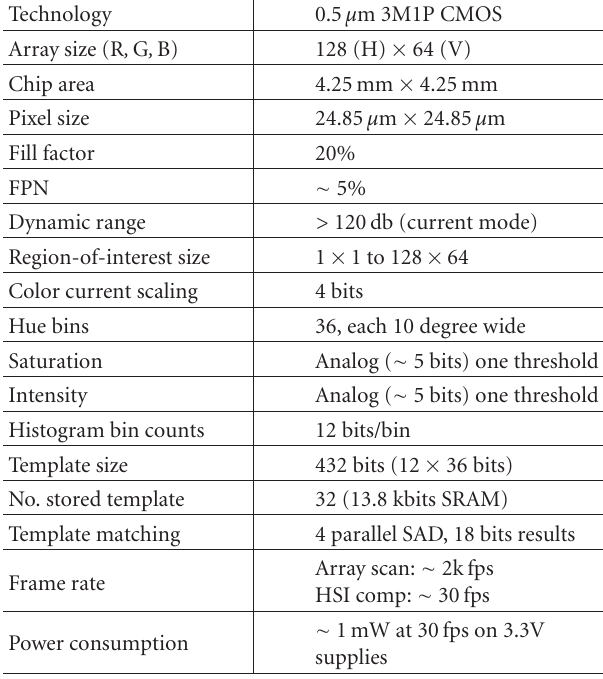
Table 1: Summary of